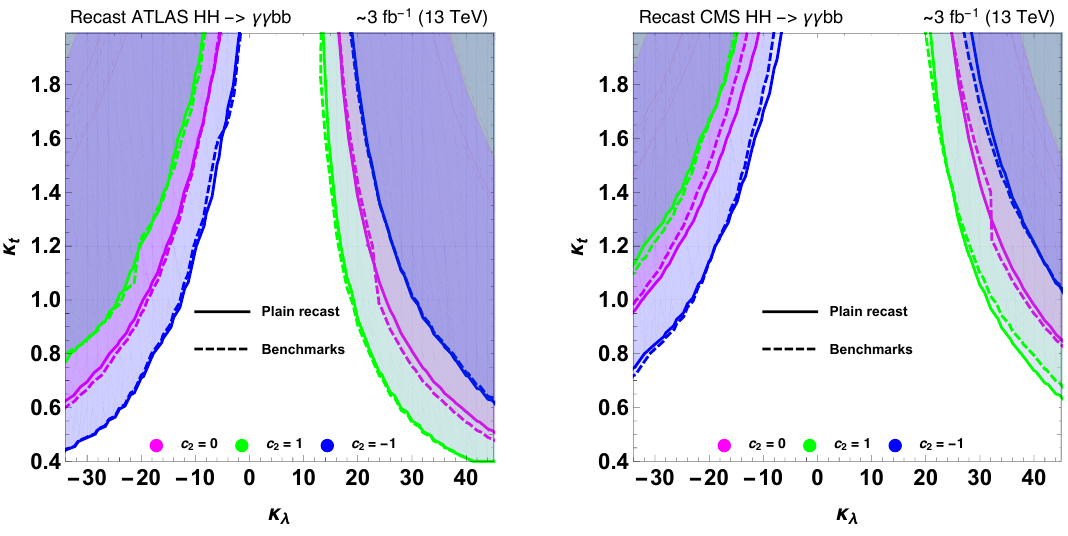
Figure 7 . Comparison between the parameter constraints obtained from a recast point by point (also shown in figure 4) and by using the limits from the recast via the closest shape benchmark in the κ λ − κ t plane for different values of c 2 .